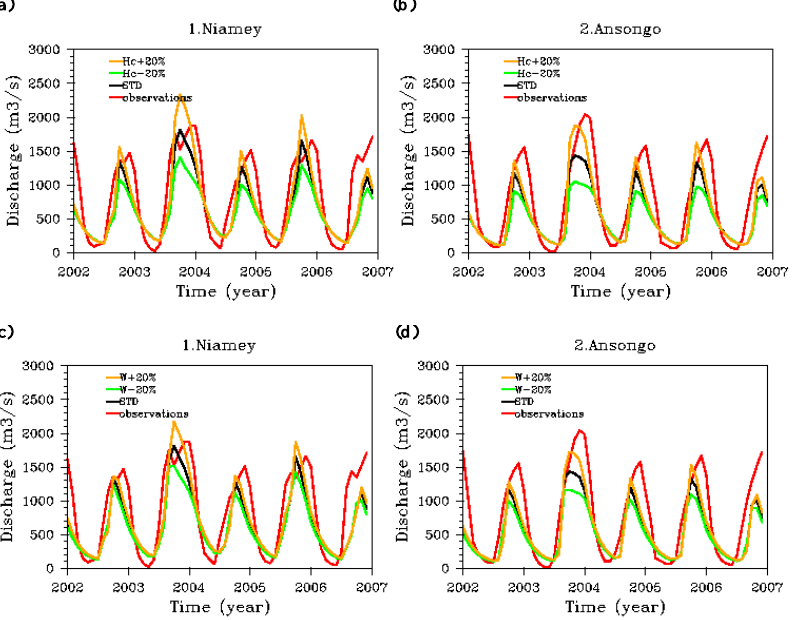
Fig. 15. Impact of modifications of the critical height h c ( a an b , up) and of the river width W ( c and d , down) on the discharge (RFEH is used as forcing). The standard run stands for the simulation AQ-F with standard parameters (used for the simulations in previous sections).